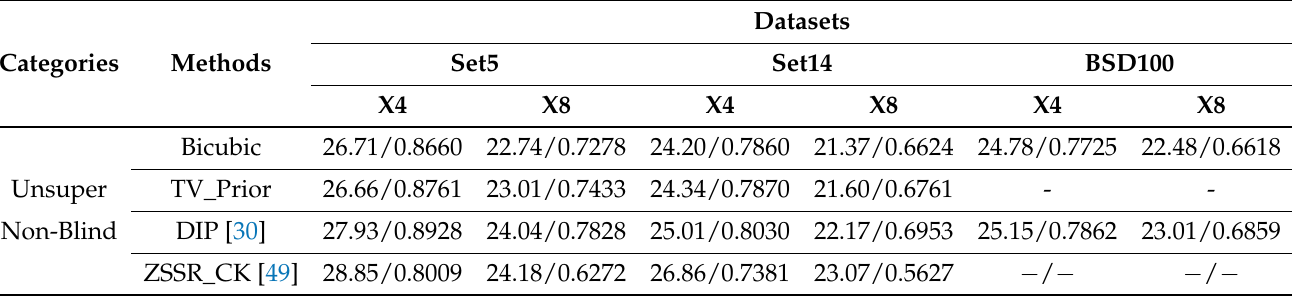
Figure 3. The compared visualization of the reconstructed HR images with different experimental settings. ( a ) The ’flower’ image in Set14 from its simulated LR images using a Gaussian blur kernel with σ = 1.0. ( b ) The ’baby’ image in Set5 from its simulated LR image using a Gaussian blur kernel with σ = 2.0. ( a ) The ’flower’ image in Set14. ( b ) The ’baby’ image in Set5. Table 3. Quantitative comparison of our proposed BSR-DUL with the sate-of-the-art methods on the simulated LR images of all three benchmark datasets. The LR images are simulated via bicubic down-sampling the ground truth HR images for a fair comparison with fully supervised methods, such as LapSRN [10] and EDSR [15]. Similarly, the first and second numerals represent the PSNR and SSIM values,